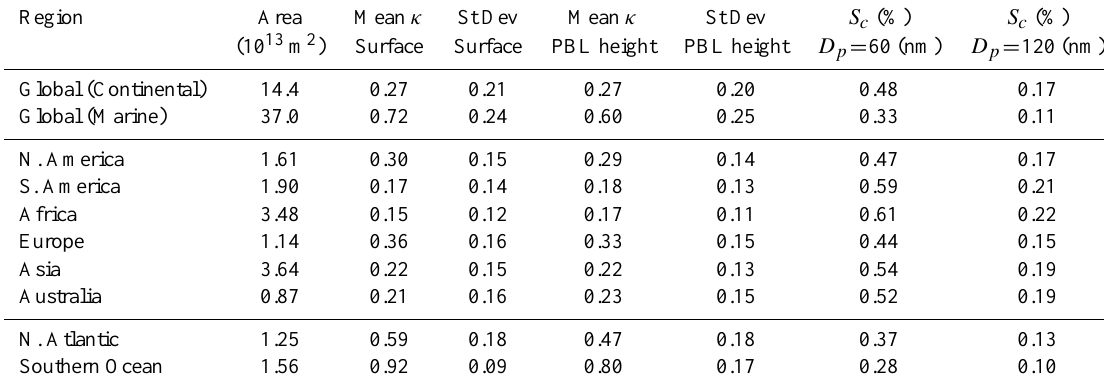
Table 1. Simulated global and regional annual mean κ values (and standard deviation (St Dev)) at the surface and at the simulated PBL height under present day conditions. Standard deviation is calculated for the year from 5-hourly average data. S c is the critical supersaturation, calculated using the regional mean κ at PBL height. Area column gives total land area for land sites, and marine area for marine sites.